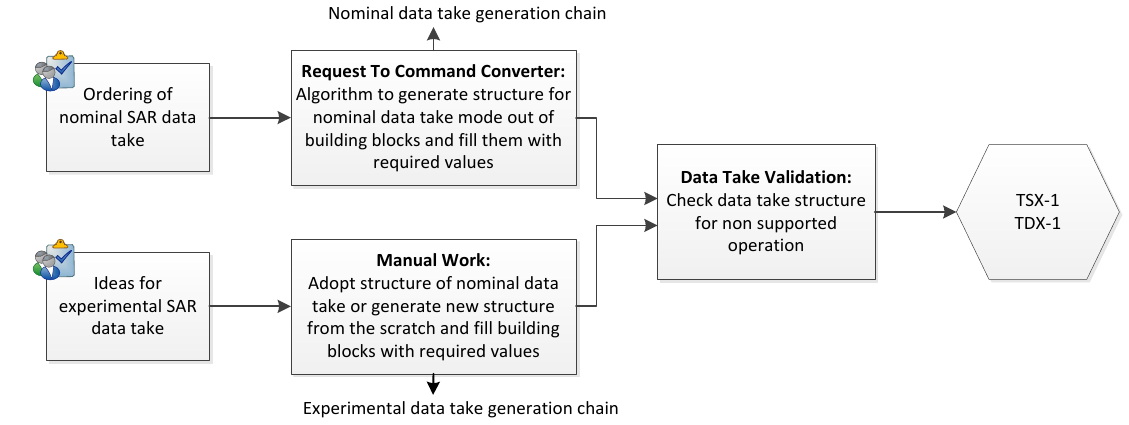
Figure 3. Data take generation chain for nominal and experimental data takes.